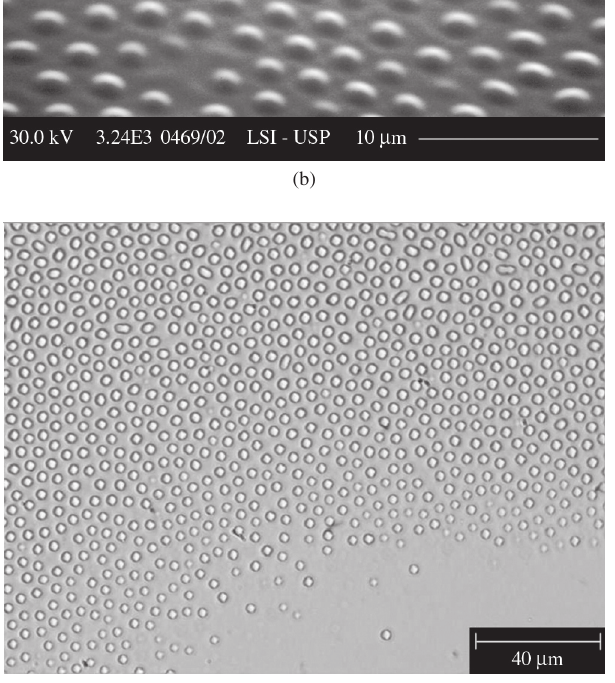
microscopy.(c) Figure 7. 2-propanol plasma (1.0 Torr, 150 W) deposited on HMDS substrate (0.5 Torr, 50 W, 1000 Å) using 40 kHz as power supply planar reactor. Images obtained by: a) AFM; b) SEM; and c) Optical